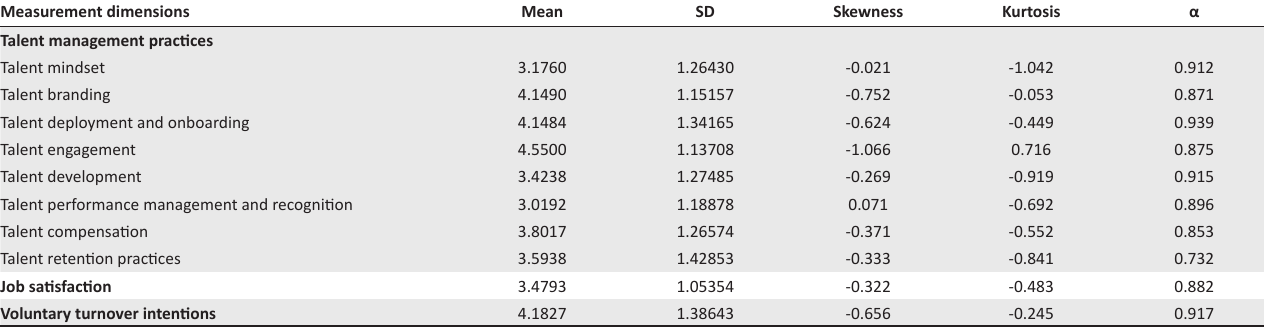
TABLE 1: Descriptive statistics and reliabilities of the measurements. Measurement dimensions